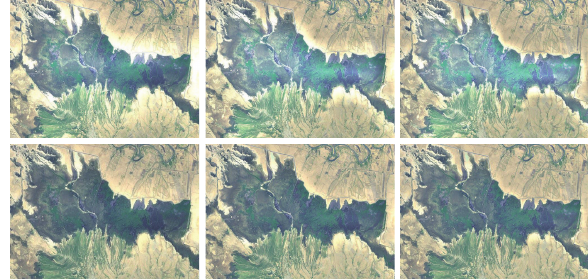
Figure 9. The corrected results of an example region on the image 19 in Figure 8(a) when setting grid points in different densities during tonal processing: 8 × 8 , 16 × 16 , and 24 × 24 , respectively, from left to right. The weight values for the l channel are set as 1.0 and 0.5 for the images in the top and bottom rows, respectively.